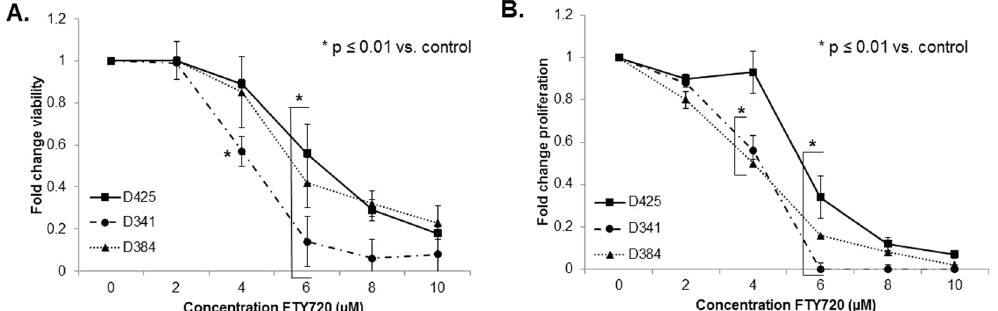
Figure 3. FTY720 treatment resulted in decreased viability and proliferation of medulloblastoma PDXs. ( A ) Cell viability was measured using alamarBlue ® assays. D425, D341 and D384 cells were treated with increasing concentrations of FTY720 for 24 hours. Viability was significantly decreased in the D341 beginning at a concentration of 4 µ M ( * p ≤ 0.01). D425 and D384 cells showed significant decreases in viability at concentrations of 6 µ M ( * p ≤ 0.01). ( B ) CellTiter 96 ® assays were used to measure proliferation. D425, D341 and D384 cells were treated with increasing concentrations of FTY720 for 24 hours. Proliferation was significantly decreased in the D341 and D384 cells at 4 µ M ( * p ≤ 0.01) and at 6 µ M ( * p ≤ 0.01) in the D425 cells. Experiments were repeated at least in triplicate and reported as mean ±